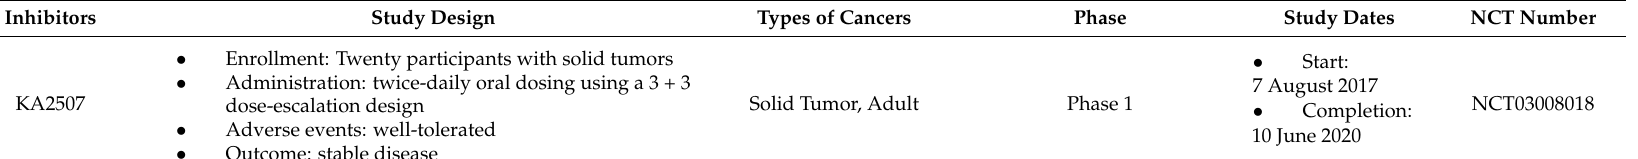
Table 5. Clinical trials of HDAC6-specific inhibitors registered in https://clinicaltrials.gov (accessed on 14 July